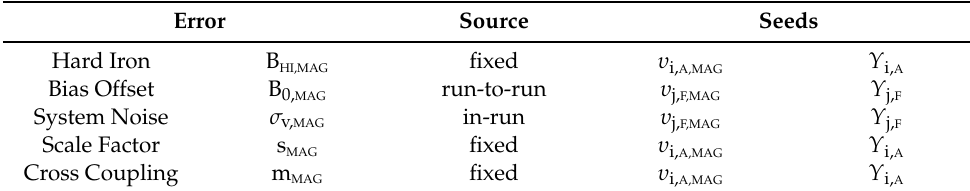
Table 6. Magnetometer error